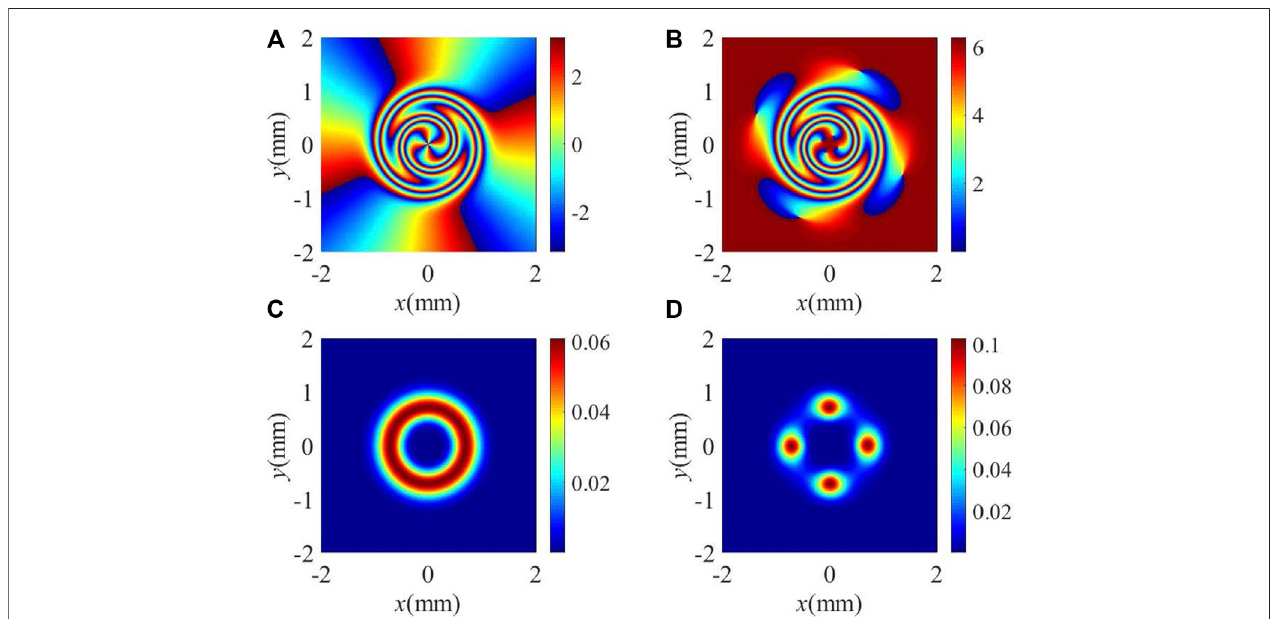
FIGURE 2 | (A,B) Phase and (C,D) intensity patterns of the FWM fi eld without and with including electronic continuum, (A,C) without including electronic continuum: γ 3 l = γ 4 l =1 meVand p =0, (B,D) withincluding electroniccontinuum: γ 3 l =1.58 meVand γ 4 l =1.50 meVand p =0.83.Otherparametersusedare γ 2 =2.36 ×10 – − 6 μ eV, γ 3 d =0.32meV, γ 4 d =0.30meV,| Ω c |=25 meV, | Ω d 0 |=30 meV, Δ c =5 meV, Δ p = Δ d =0,and κ m = κ p =9.6 ×10 3 μ m − 1 meV, l =4, p =0, w 0 =500 μ m,and L = 1 μ m.